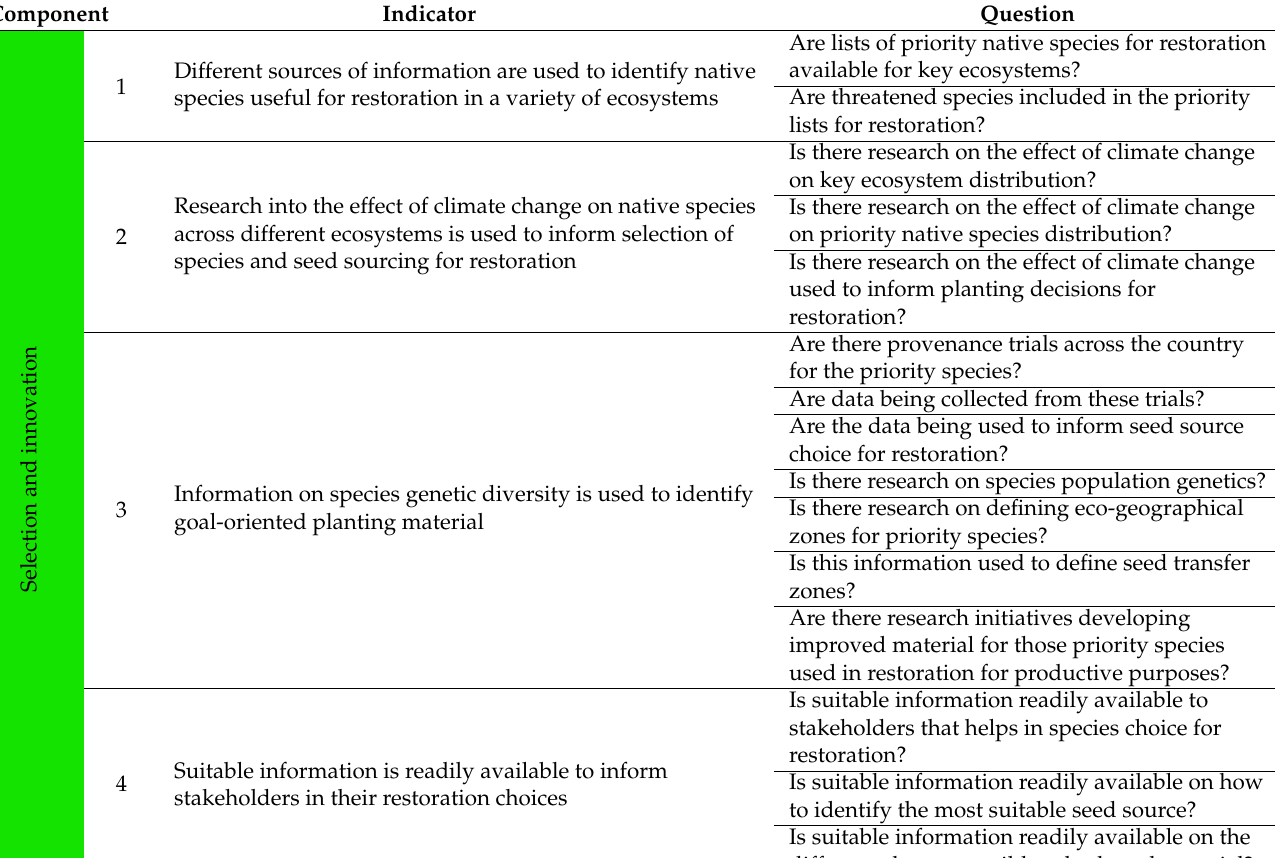
Table 1. The indicator component titles, underlying indicators, and corresponding questions that make up the set of indicators for the analysis of tree seed systems. Component Indicator